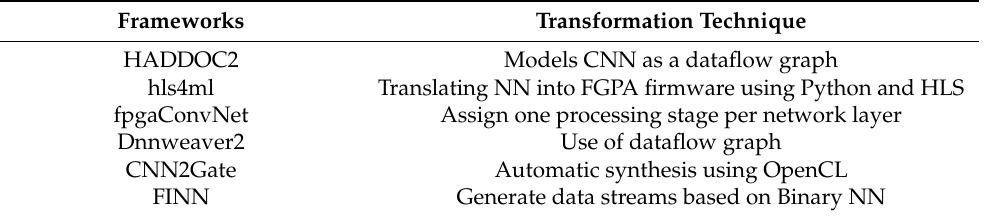
Table 1. Available frameworks for